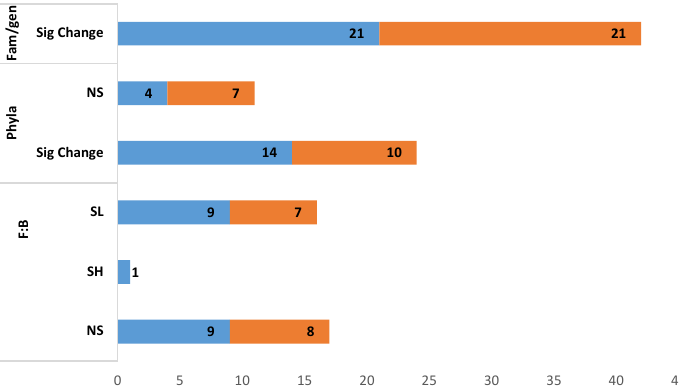
Figure 3. Effect of polyphenols on Firmicutes:Bacteroidetes ratio, phyla, and family/genus. SL- Significantly Low, SH-Significantly High, Sig change-significant changes, NS-Not Significant, Fam-family, gen-genus. Significance/non-significance compared to HFD. Studies that tested more than one compound/dose: [45,54,57,58,62,63].